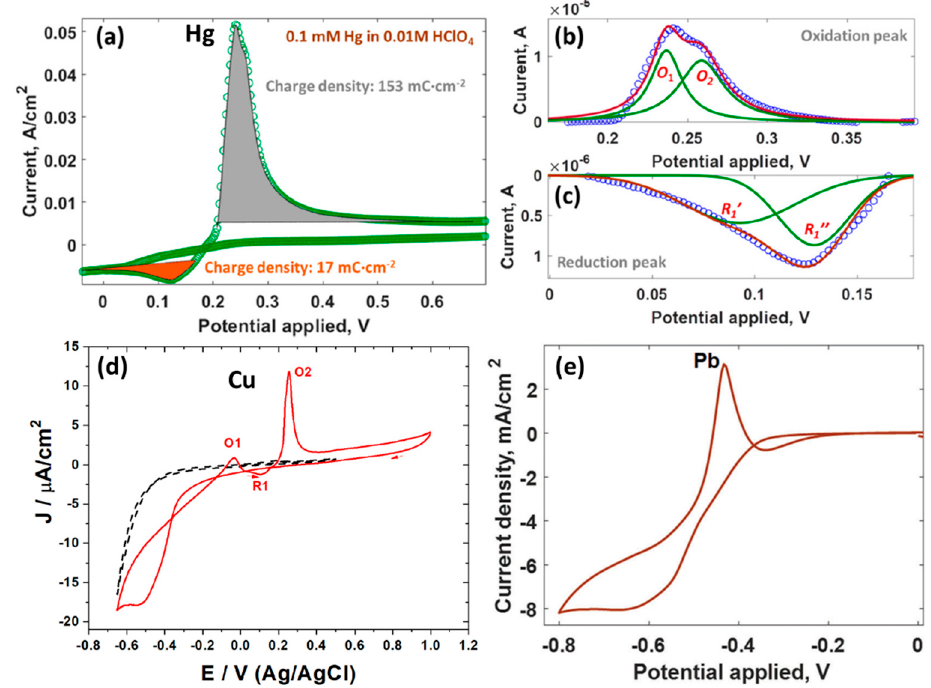
Figure 11. Cyclic voltammograms registered at the epitaxial graphene electrode in the presence of mercury [51] ( a – c ) (Copyright 2019 by the authors), copper [52] ( d ) (Copyright 2020 by the authors), and lead [50] ( e ) (Copyright the Owner Societies 2018).